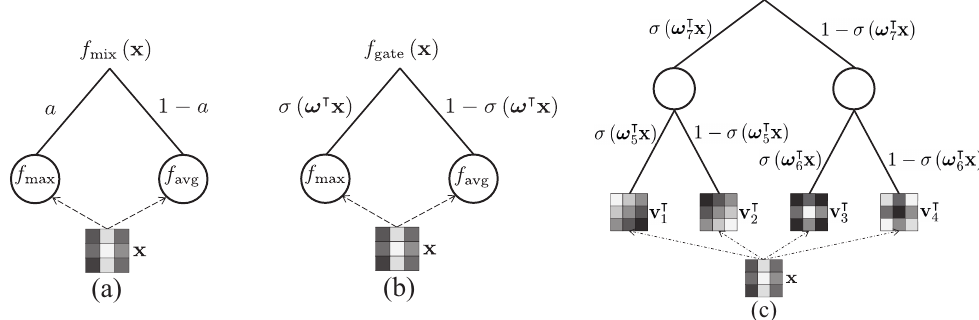
Figure 4. A schematic comparison of the three proposed operations in [19]: ( a ) mixed Max–Average pooling, ( b ) gated Max–Average pooling and ( c ) tree pooling with 3-level binary